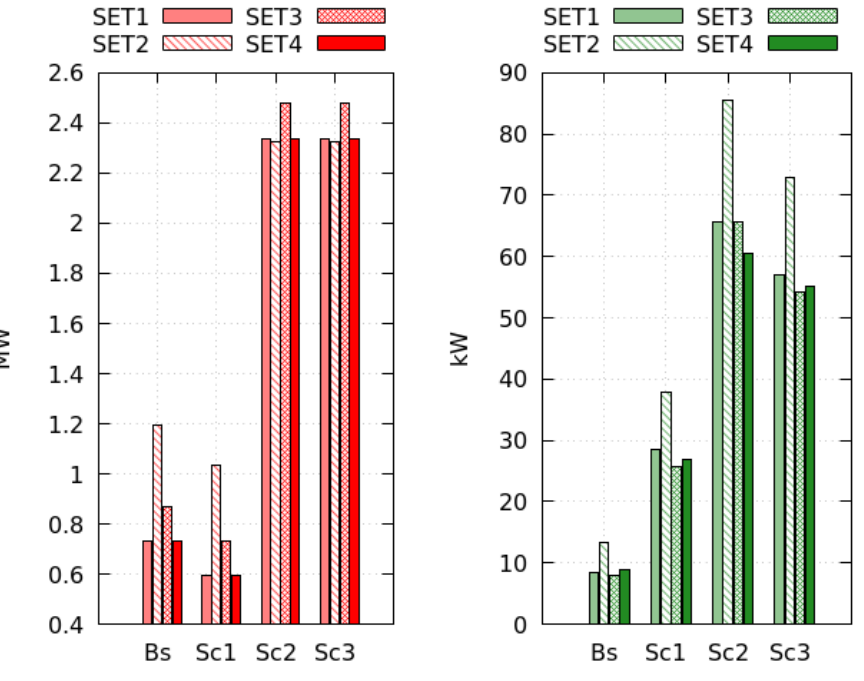
Figure 10. The heating ( red ) and flowing loads ( green